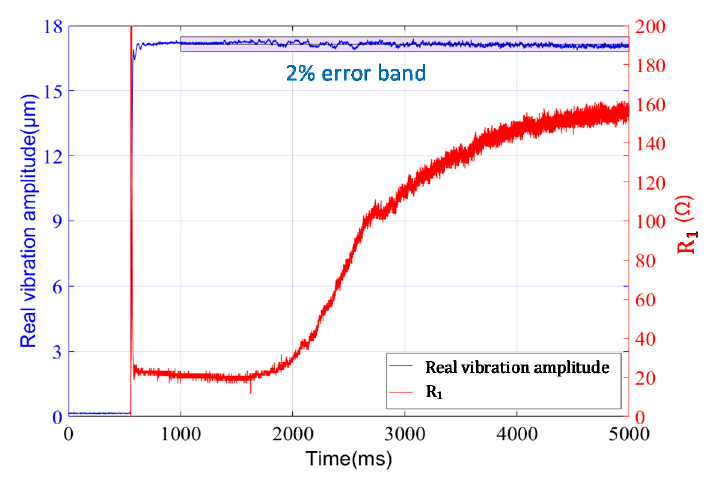
Figure 17. Variation in vibration amplitude under varying load.